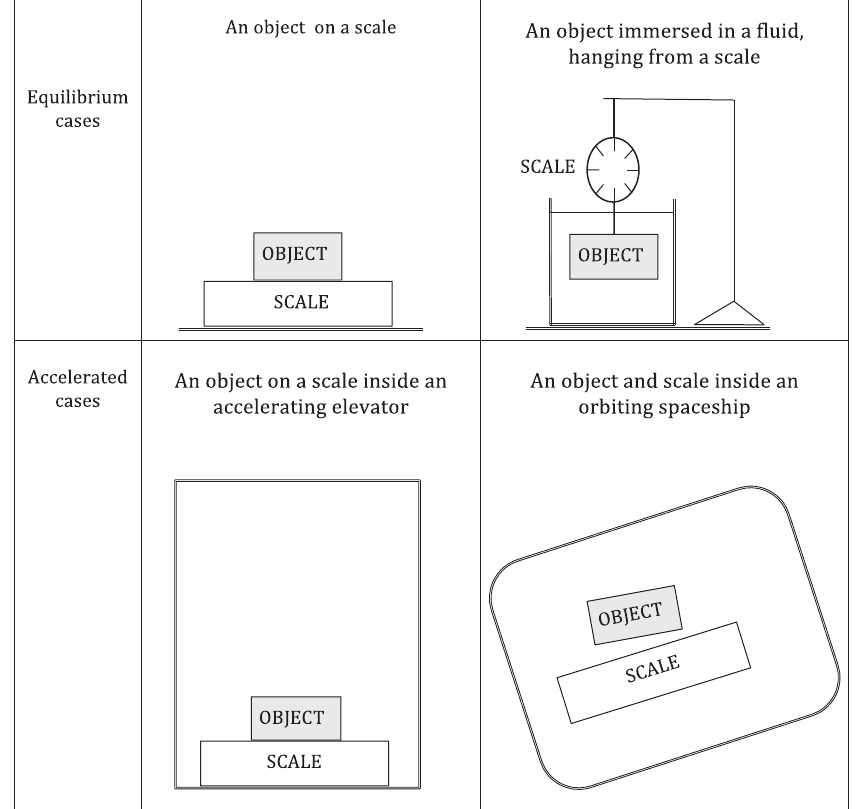
FIG. 1. Various equilibrium and accelerated cases involving gravitational force and scale contact